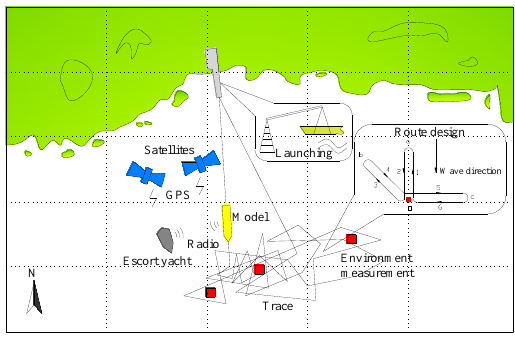
Figure 25. Experimental procedure.